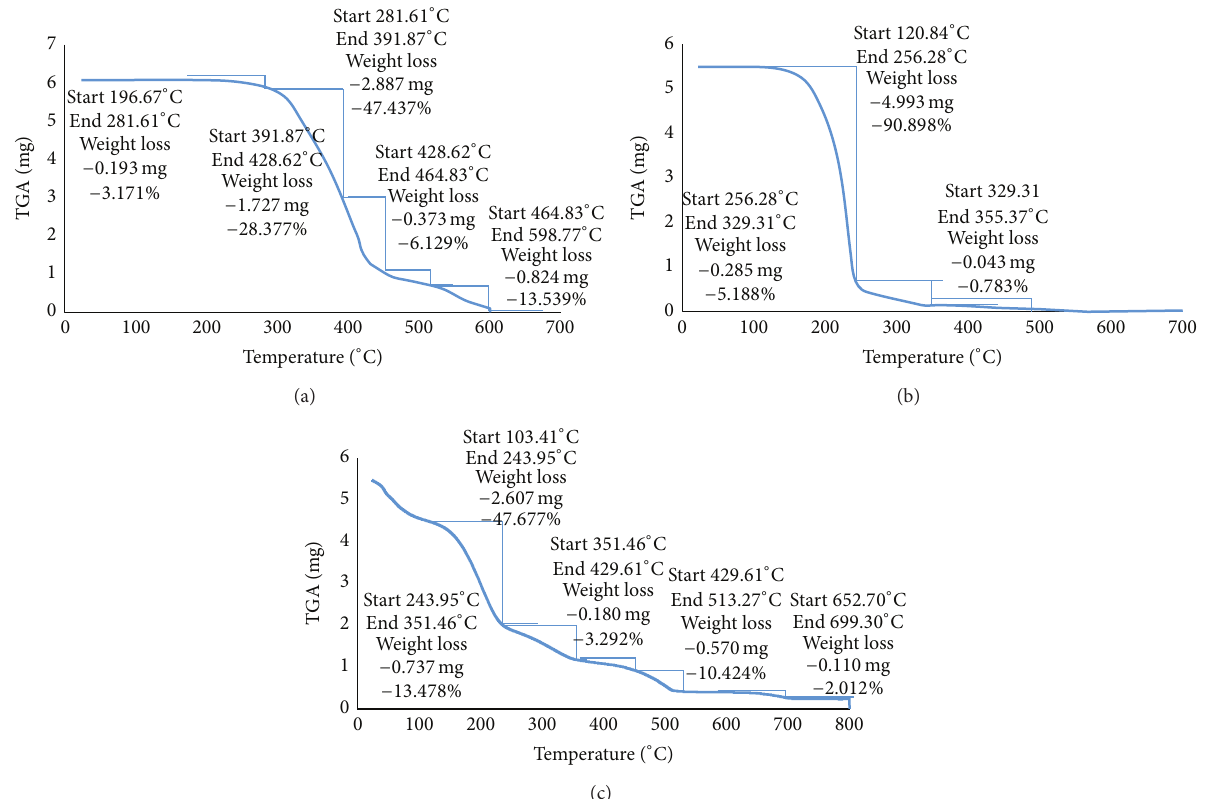
Figure 7: (a) TGA diagram for waste vegetable oil. (b) TGA diagram for biodiesel produced at optimum conditions. (c) TGA diagram for biodiesel produced at high reactant flow rates.